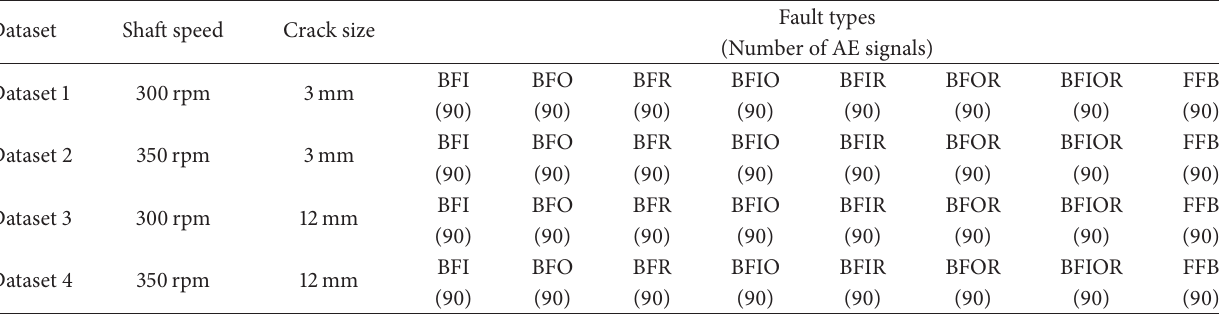
Table 1: Datasets for the proposed bearing fault diagnosis